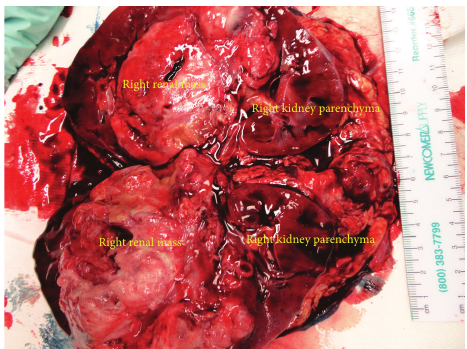
Figure 3: Gross specimen after en bloc removal and then transec- tion by